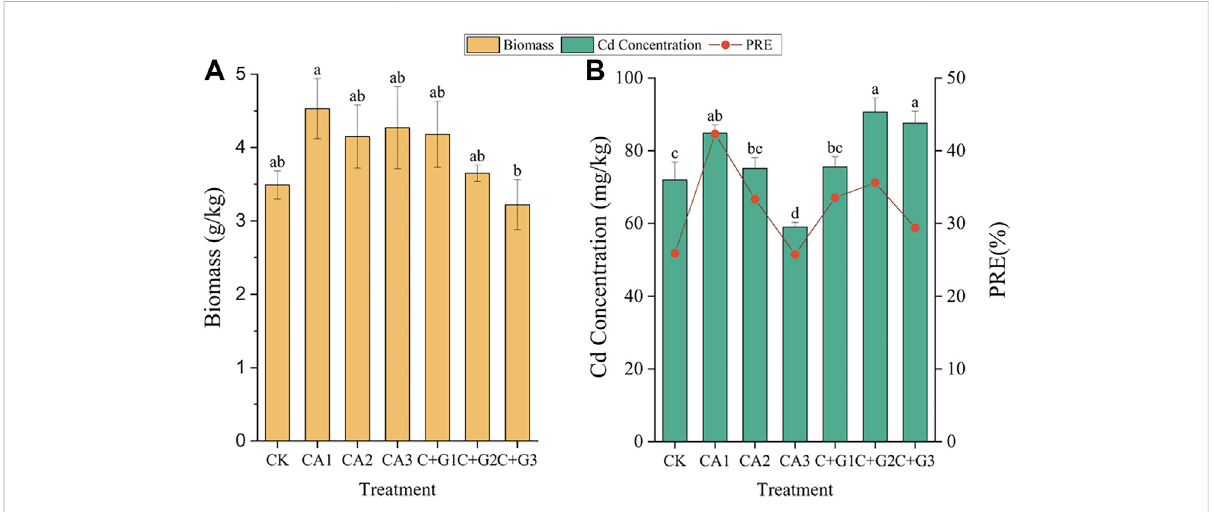
FIGURE 7 Changesinthebiomass (A) andCd concentrationin S.plumbizincicola (B) under differentfractionsanddosagesofsingle citric acidapplication and its combination with Gly. The remediation ef fi ciency of Cd was evaluated by calculating the absorption rate of Cd in S. plumbizincicola (B) (Different letters indicate signi fi cant differences. Biomass: p < 0.1; Cd concentration: p <